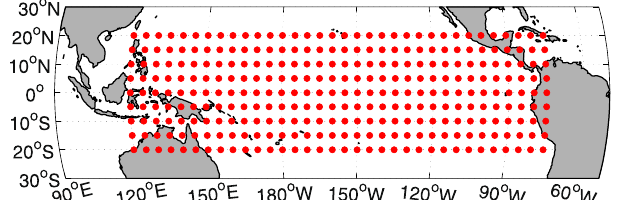
Figure 1. Surface air temperature network. In this study, 306 nodes with a resolution of 5° × 5° were selected and the corresponding surface air temperatures were constructed as a climate network. The figure was generated using Matlab (version R2012a, http://www.mathworks.com/pl_homepage).